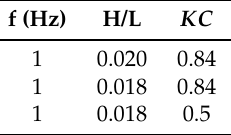
Table 1. Wave-heave plate interaction test matrix. H/L is the wave steepness.